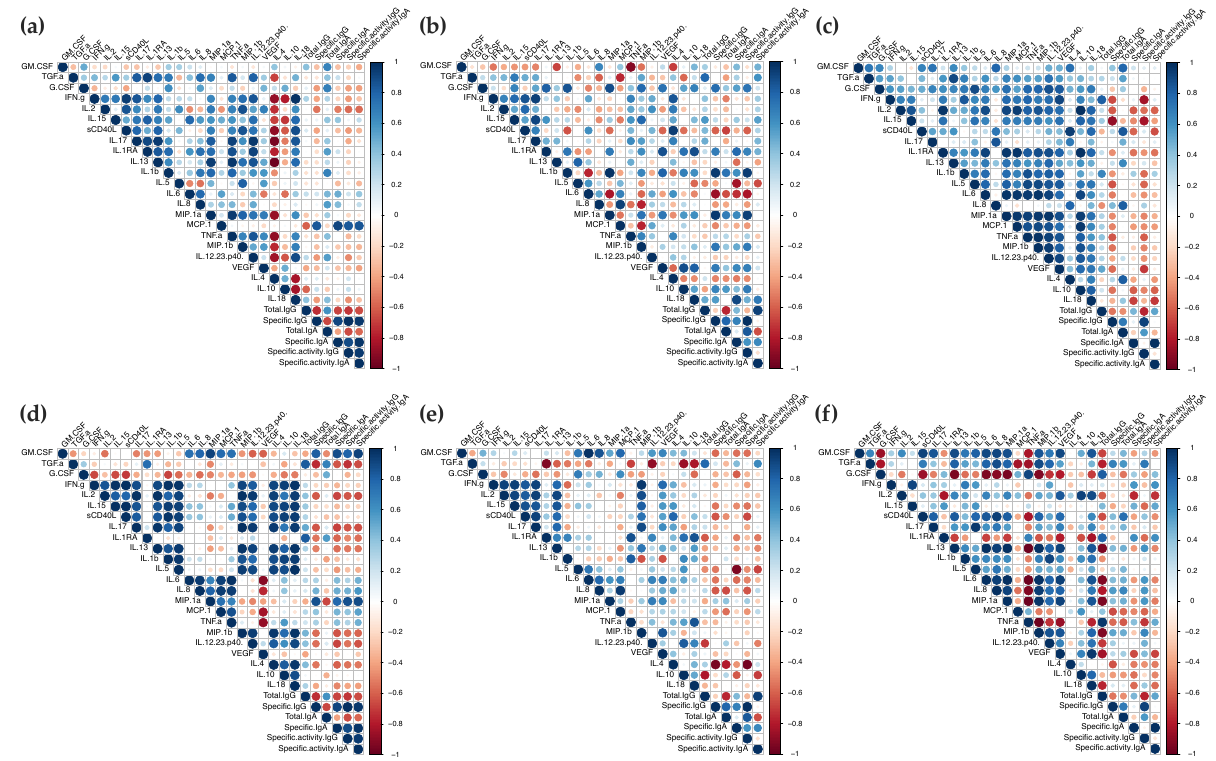
Figure 4. Correlogram of the vaccine responses elicited in the mucosal and systemic compartments. The correlations between the levels of secreted cytokines and the concentrations of total, gp120- specific and the specific activity of IgG and IgA in cervical tissue ( a , d ), rectal explants ( b , e ), and serum ( c , f ) at week 26 ( a – c ) or week 6 ( d – f ) were analyzed by a correlation matrix. Positive Pearson correlation coefficients are displayed in blue and negative correlations are displayed in red. The color intensity indicated in the side bar is proportional to the correlation coefficient. The size of the circle is proportional to the statistical significance of the correlation. Statistical significance from p ≤